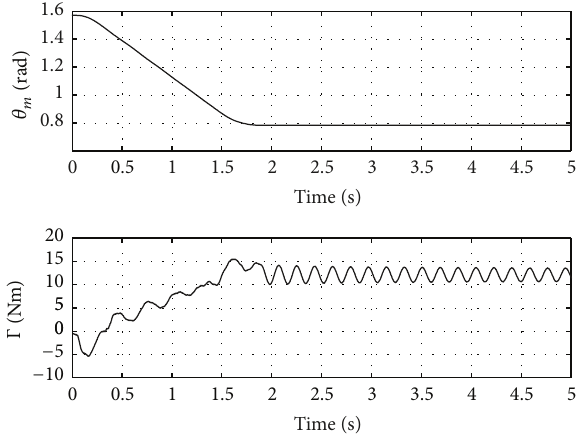
Figure 4: Experiment type 1: motor position and torque measure- ment for mass 𝑚 2 .